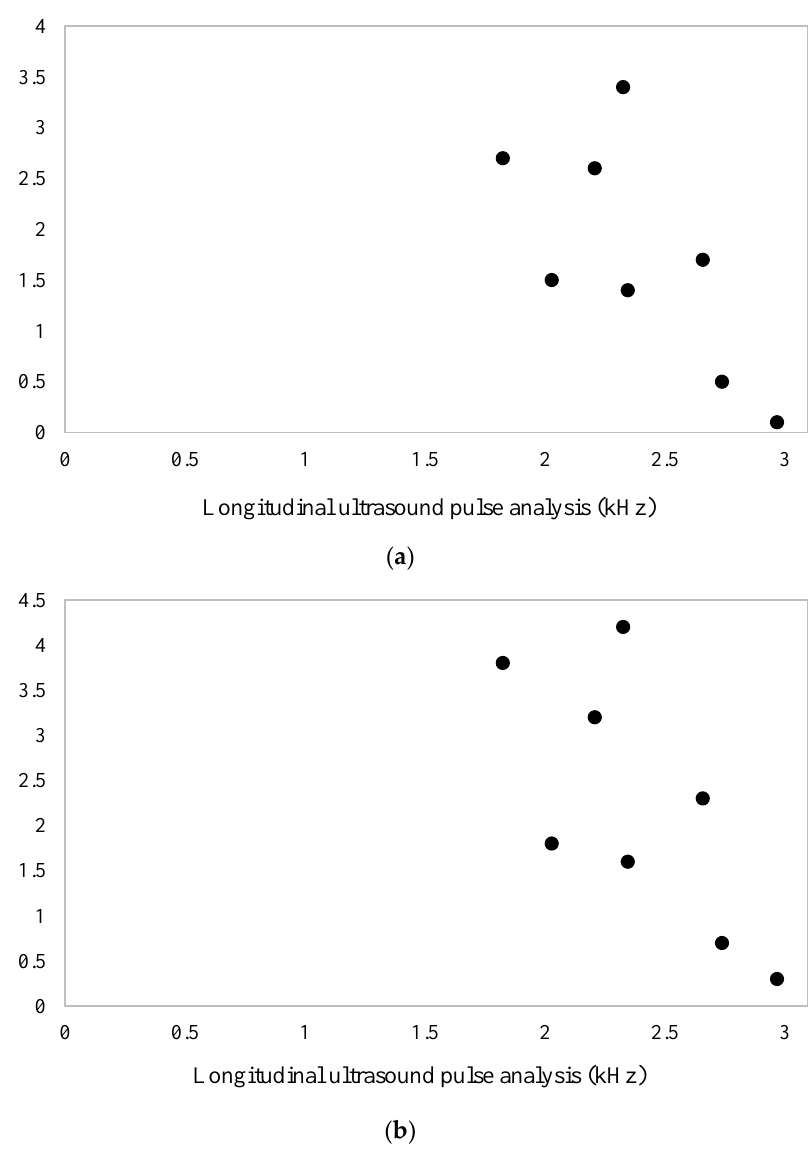
Figure 8. Strong regression relationship for the estimation of bending strength from the longitudinal UPA on ( a ) the 28th day and ( b ) the 180th